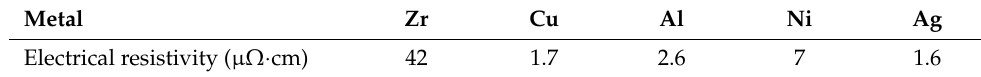
Figure 7. Electrical resistivities of films deposited with (continuous lines) and without (dotted lines) bias at 60 (black) and 200 °C (red), for the different Ag contents, accompanied by corresponding cross-section SEM (30 at.% Ag, floating, 60 °C) and STEM images (7.5 – 30 at.% Ag, floating, 200 °C). Table 3. Electrical resistivities of metals of interest at 20 °C.